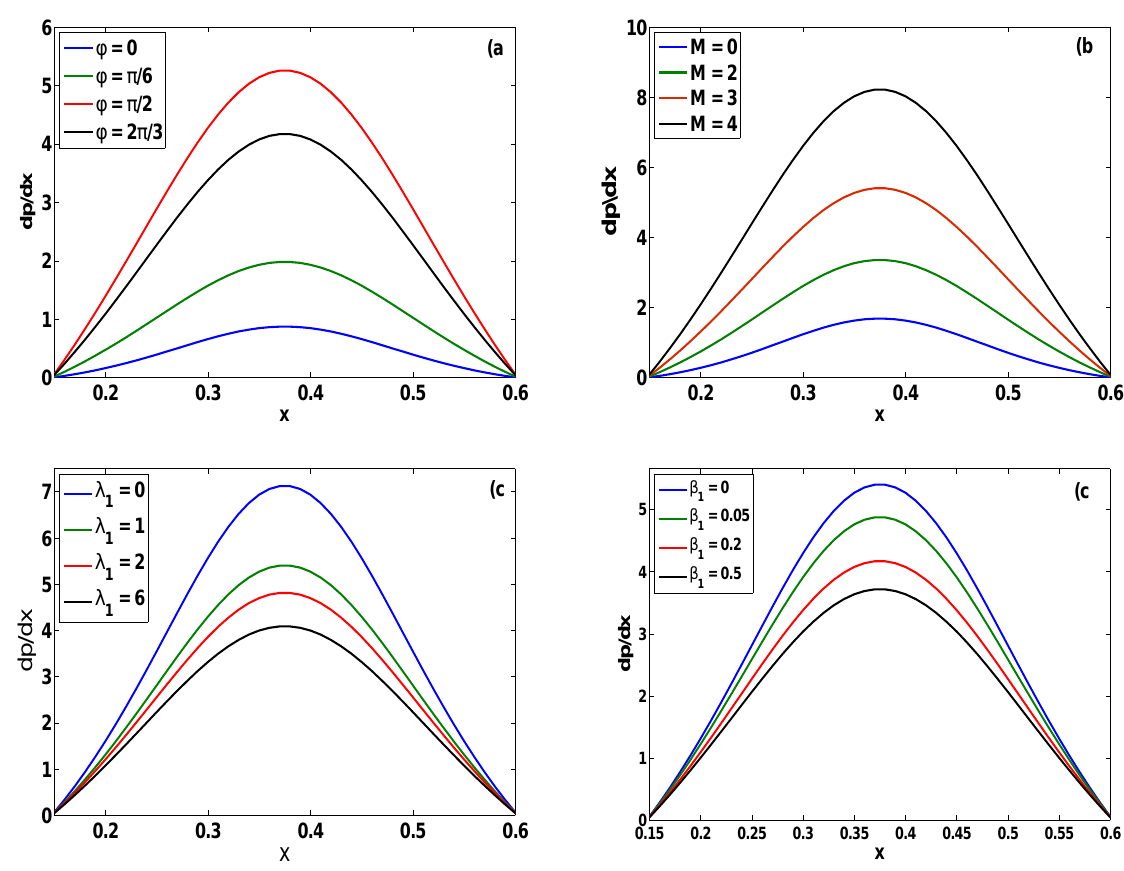
Figure 3. dp / dx (pressure gradient) vs x ∈ [ − 0.5,0.5 ] for Q = 0.1, ( a ) : M = 4, β 1 = 0.2, λ 1 = 1, ( b ) : ϕ = π /4, β 1 = 0.2, λ 1 = 1, ( c ) : ϕ = π /4, β 1 = 0.2, M = 4, ( d ) : M = 4, λ 1 = 1, ϕ = π /4.